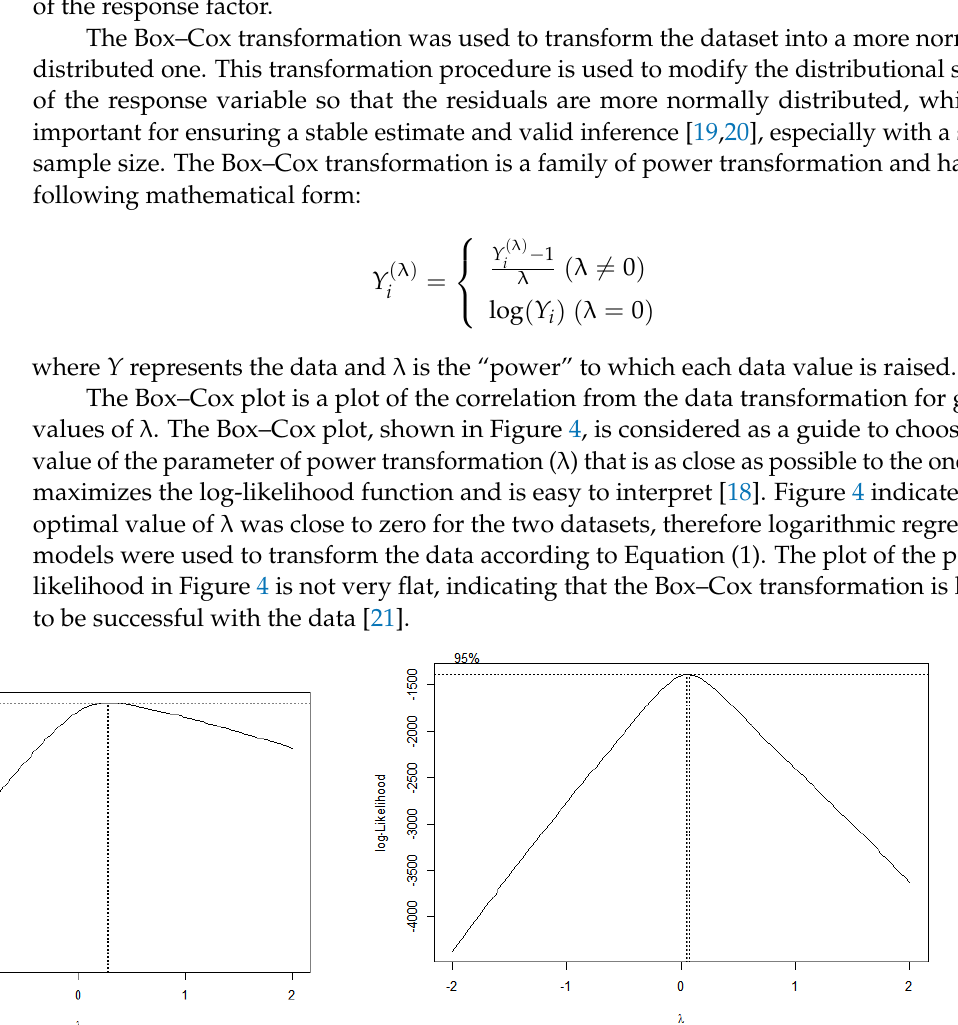
Figure 4. Profile–likelihood plot for the Box–Cox transformation of the VTI data ( left ) and NMF data Figure 4. Profile – likelihood plot for the Box – Cox transformation of the VTI data ( left ) and NMF ( right data ( right ).